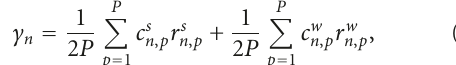
Figure 6: Decomposition of v p ( l ) into contiguous overlapping win- dows g n